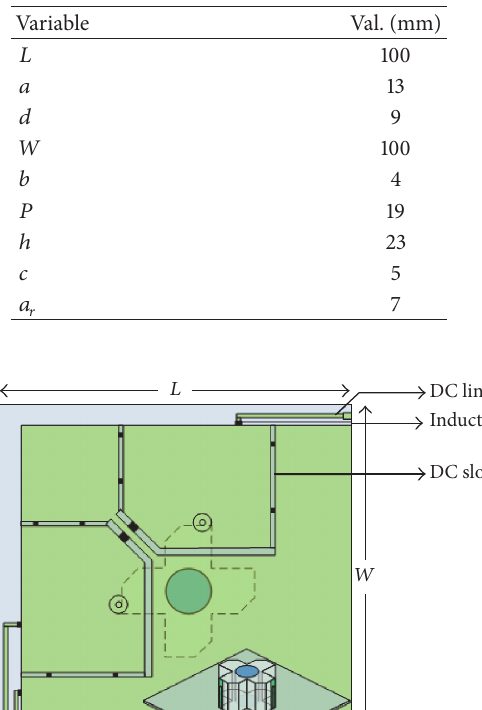
Table 1: MIMO antenna design parameters.